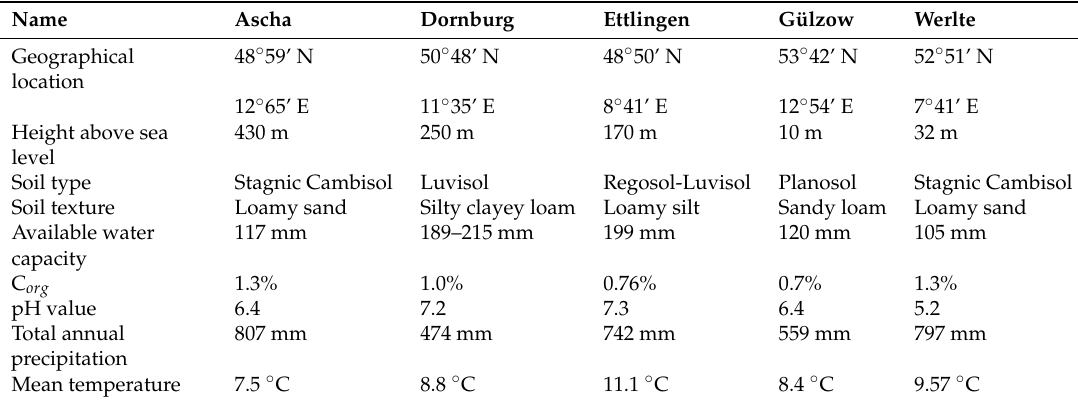
Table 1. Characteristics of the experimental sites. Soil type is specified according to the FAO classification system. C org refers to the first 30 cm of the top soil layer. Total annual precipitation and mean temperature are averaged between 1971 and 2000.